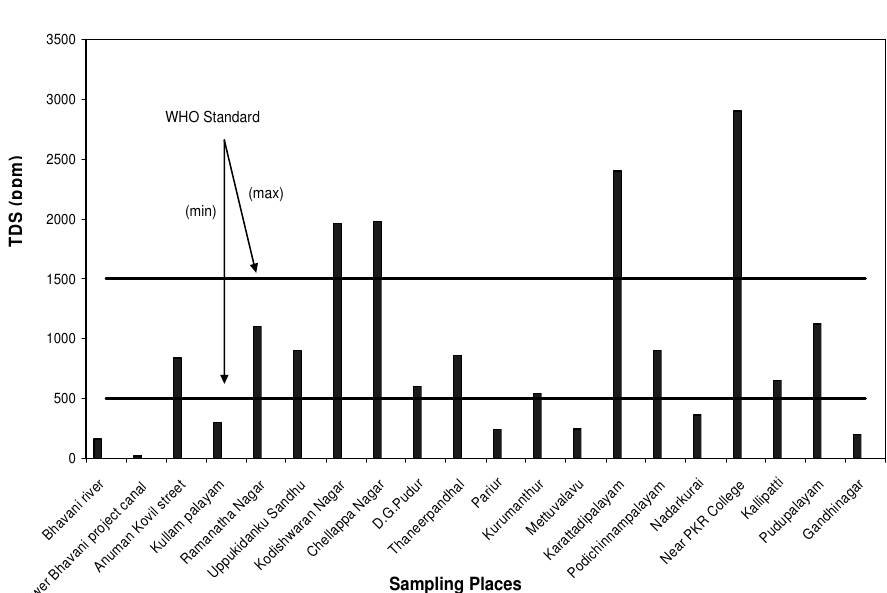
Fig.2. Total Dissolved Solids (ppm) of Various Water Samples Colleceted in